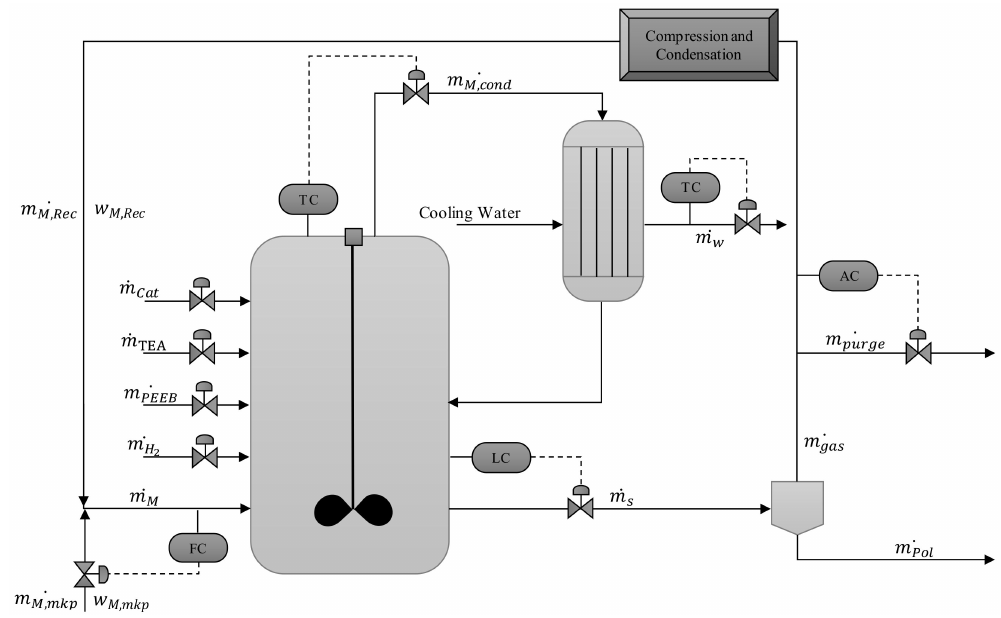
Figure 6. Process flow